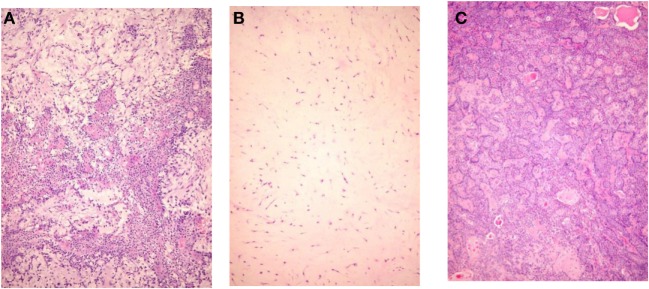
Histological subtypes of pleomorphic adenoma. (A) Classic type, (B) myxoid type, and (C) hypercellular type.